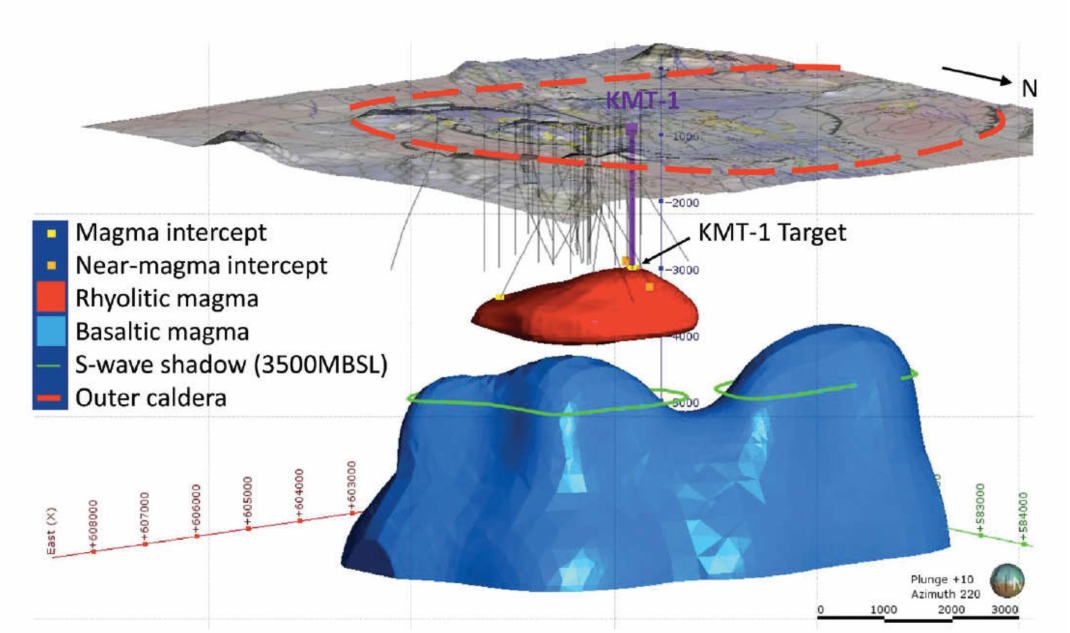
Figure 3. Idealized configuration of rhyolitic magma body (red) and deeper basaltic body (blue) under Krafla Caldera (red dashed line). Light gray lines are existing wells drilled by Landsvirkjun